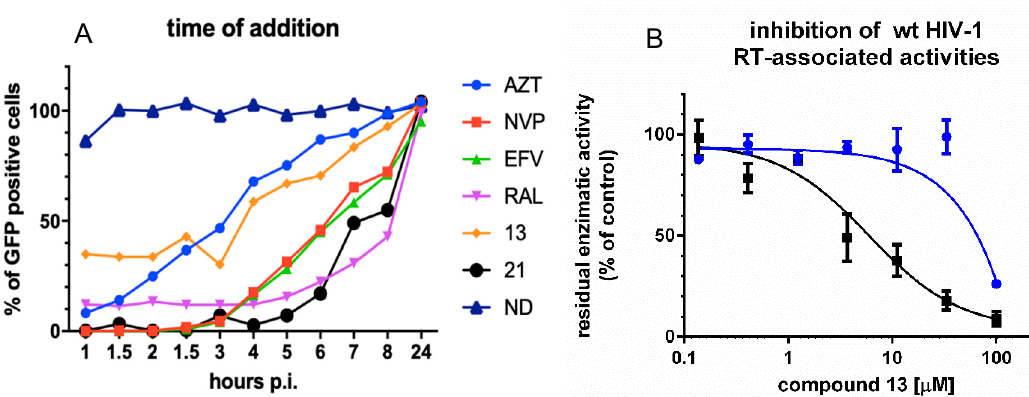
Figure 2. Analysis of compound 13 target of inhibition. ( A ) Time-of-addition. Drugs were used at the following final concentrations: AZT 3.7 µ M; NVP 3.7 µ M; EFV 0.3 µ M; RAL 2 25 µ M; compound 13 25 µ M; compound 21 25 µ M. Twenty-four hours post infection GFP expression was quantified by FACS. A representative assay of two is shown; ( B ) comparative inhibition of HIV-1 RT-associated activities. RT-associated RNase H activity black line, RDDP blue line. Assays were run in duplicate; the graph represents values the mean and standard deviation of two independent